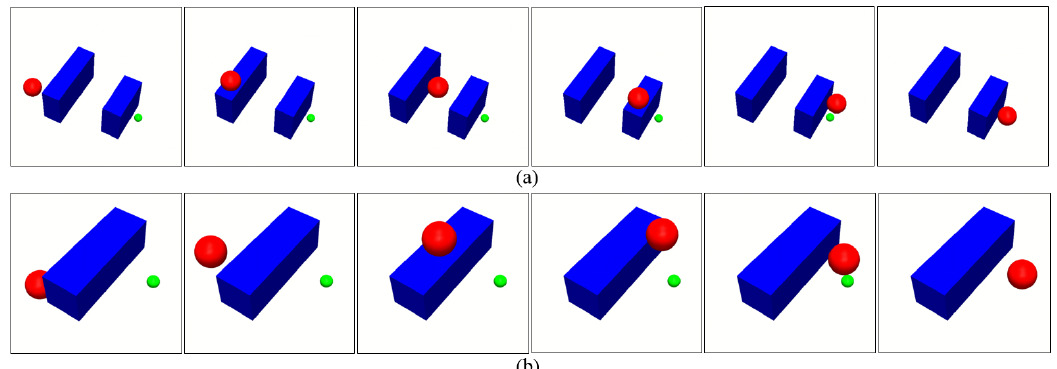
Figure 8. Frames captured from the final policies trained with our proposed method deployed on manipulation tasks in simulated environments. ( a ) two obstacles. ( b ) one obstacle. Best viewed in color.